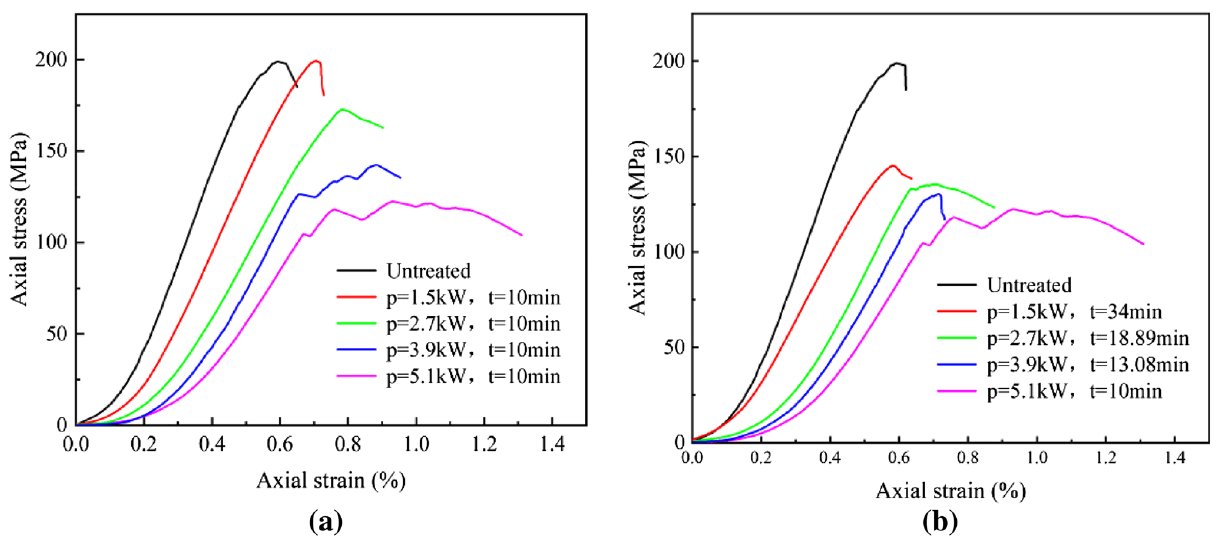
Figure 8. The stress–strain curves of treated basalt under uniaxial compression. ( a ) Microwave irradiation time t = 10 min; ( b ) Microwave energy 3060 kJ.